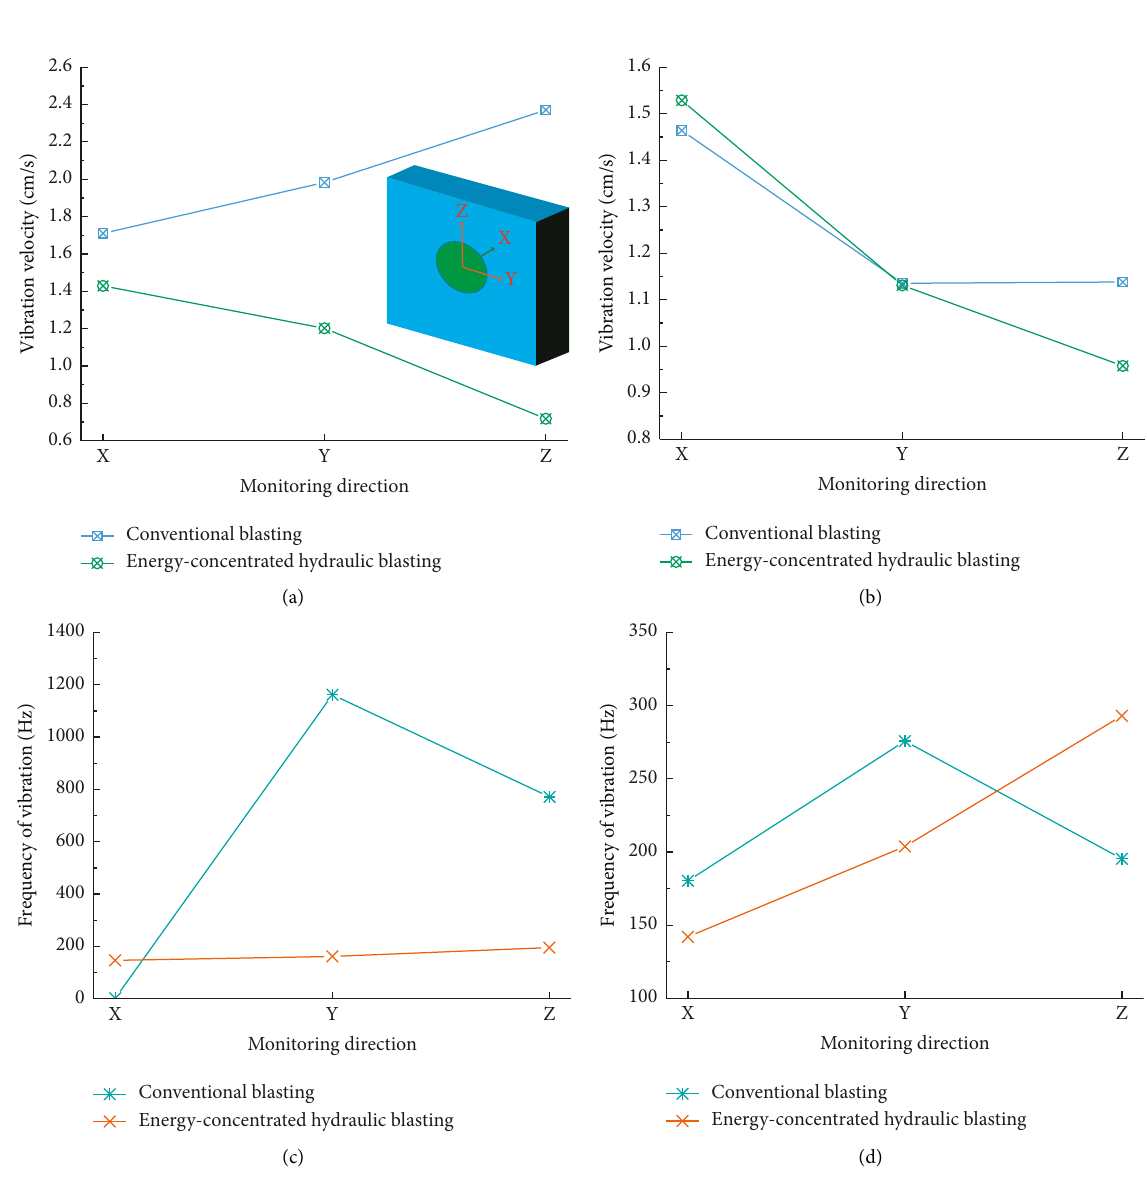
Figure 16: Monitoring results. (a) Vibration velocity of test 1. (b) Vibration velocity of test 2. (c) Vibration frequency of test 1. (d) Vibration frequency of test 2